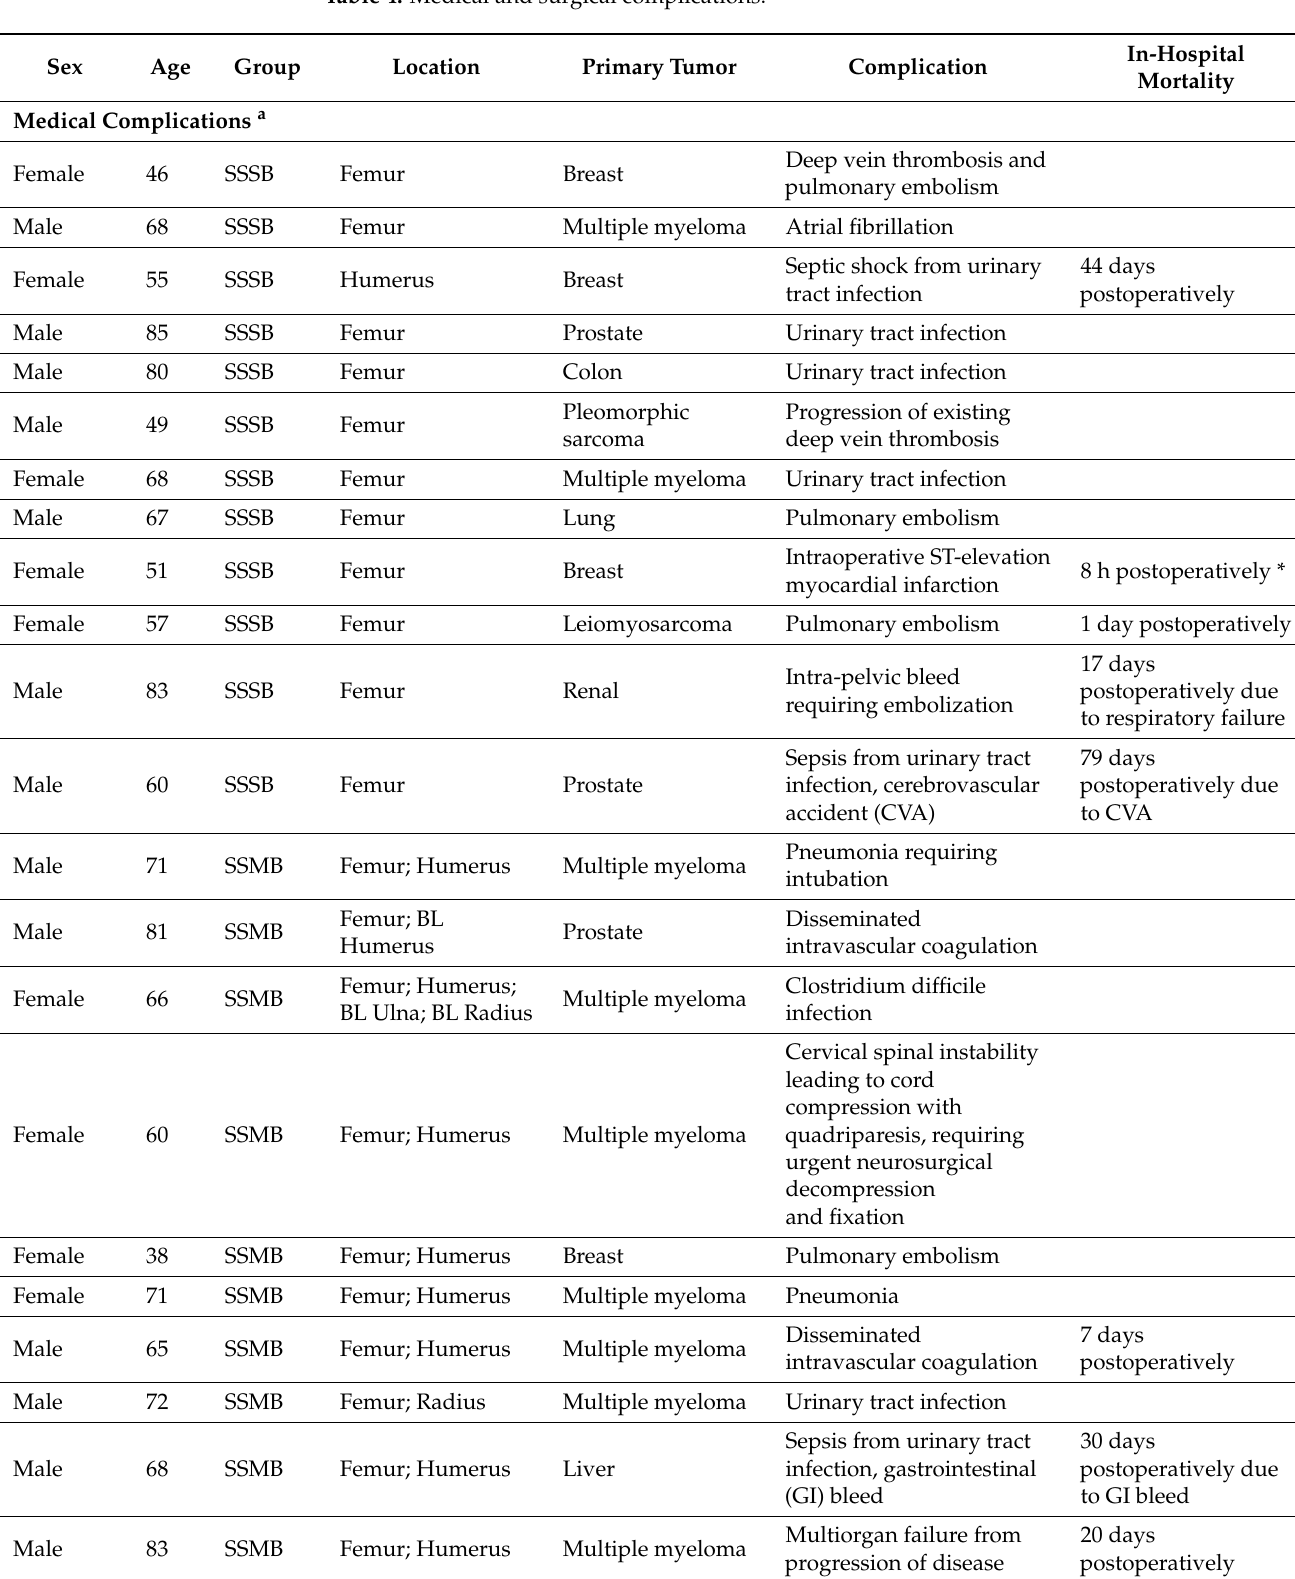
Table 4. Medical and surgical